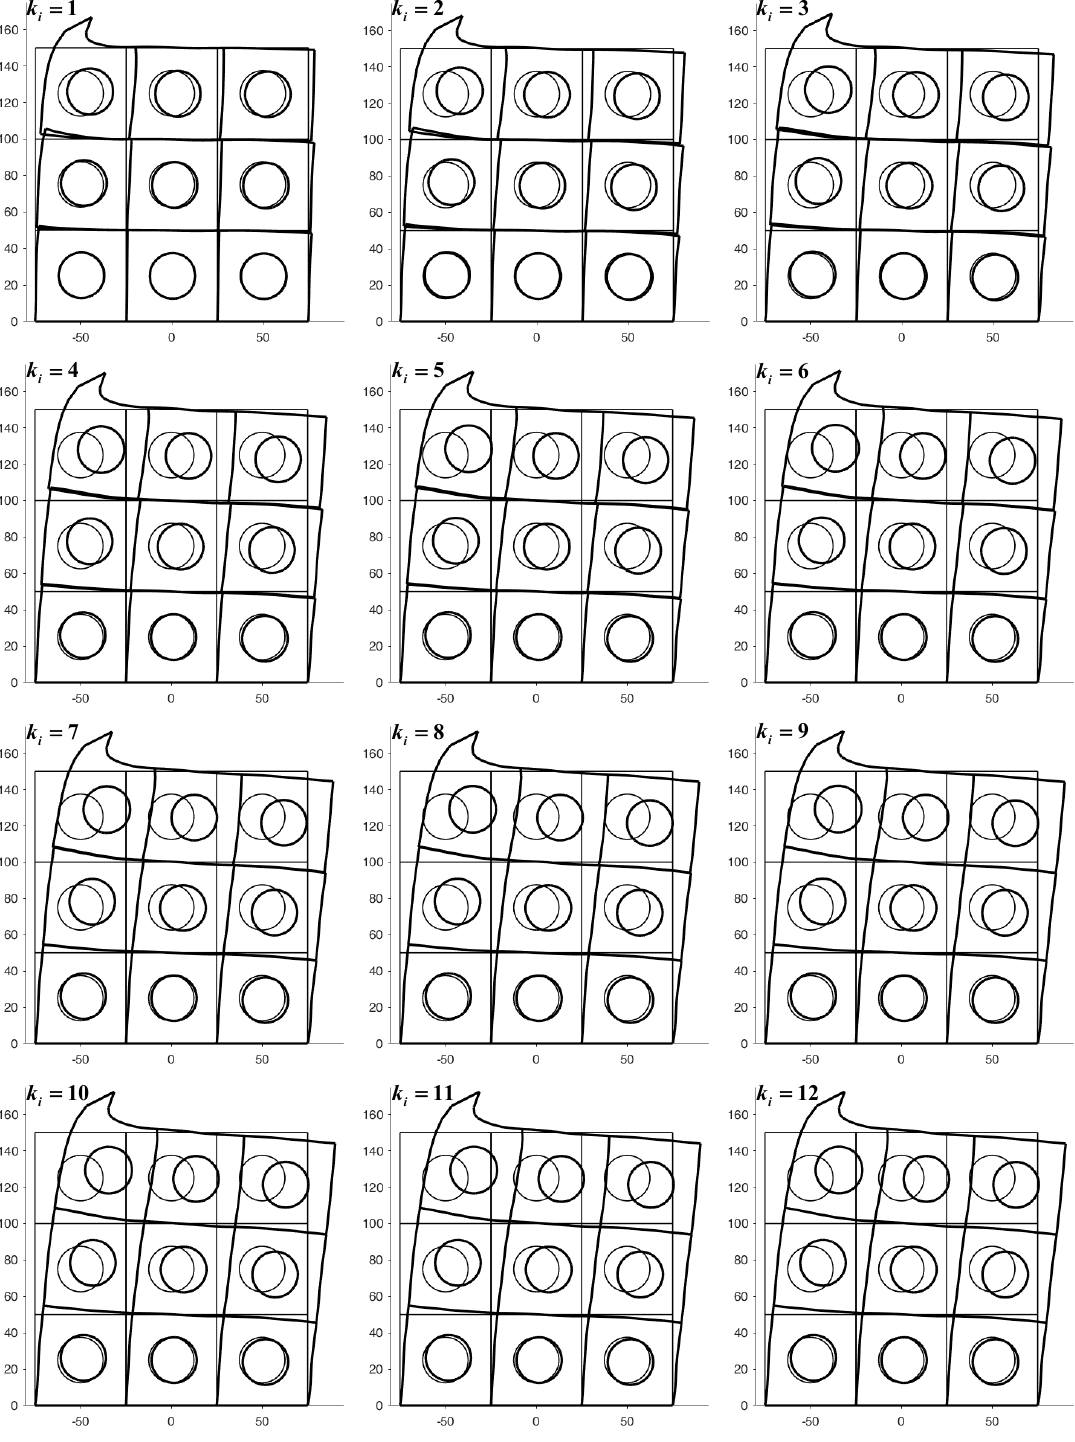
Stabilization cycle on the rows: deformed configurations provided by the k i -th top-to-bottom-to-top iteration, for 1 ≤ k i ≤ 12 (Thin line: undeformed configurations. Thick line: deformed configurations. Amplification factor of the displacements: k = 200 ).